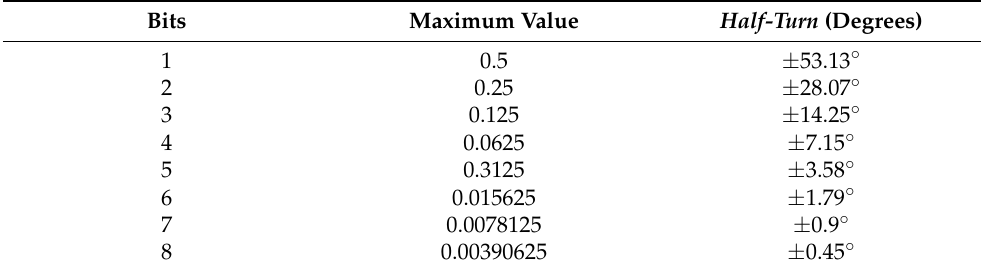
Table 2. Relation between bits for the fractional part and half-turns in